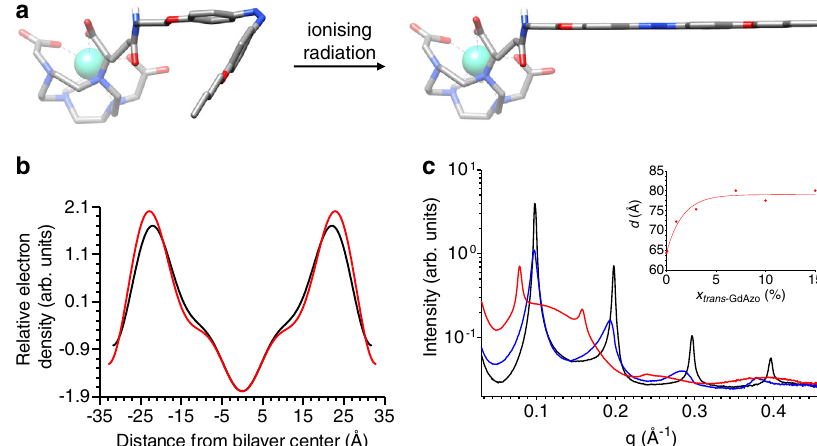
Fig. 6 Geometrical structure of GdAzo and insertion within model phospholipid membrane. a Structures of cis - GdAzo (left) and trans - GdAzo (right) calculated at the B3LYP/6-31 G* level of theory. b Electronic density of the DPPC model phospholipid membrane in the presence of trans - GdAzo (0.1%) extracted from SAXS experiments (black, red: x trans - GdAzo = 0, 0.1%, respectively). c SAXS patterns of mixtures of DPPC and trans - GdAzo (black, blue, red: x trans = 0, 0.1, 7%, respectively). Inset: Variation of the d -spacing as a function of trans - GdAzo molar - GdAzo